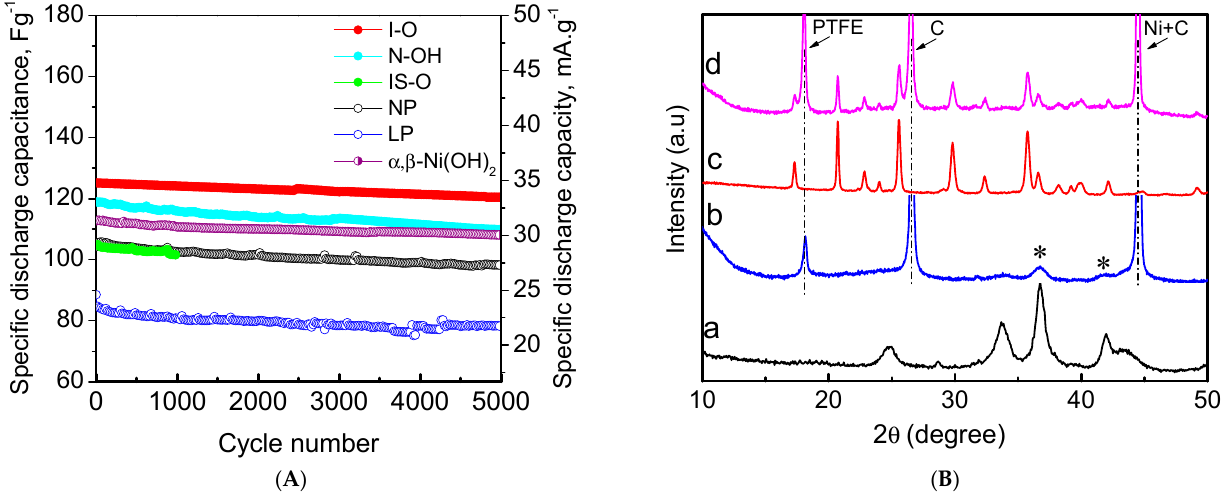
Figure 6. ( A ) Specific discharge capacitance (capacity) as a function of the cycle number at 240 mA g − 1 of supercapacitor cells with different composite electrodes. ( B ) Ex situ XRD patterns of ilmenite (b) and phospho-olivine (d) electrodes after 5000 cycles. For the sake of comparison, the pristine ilmenite (a) and phospho-olivine (c) are also given. Symbols (*), (PTFE), (C) and (Ni) denote the peaks due to the ilmenite phase, PTFE, graphite and Ni foam, respectively.